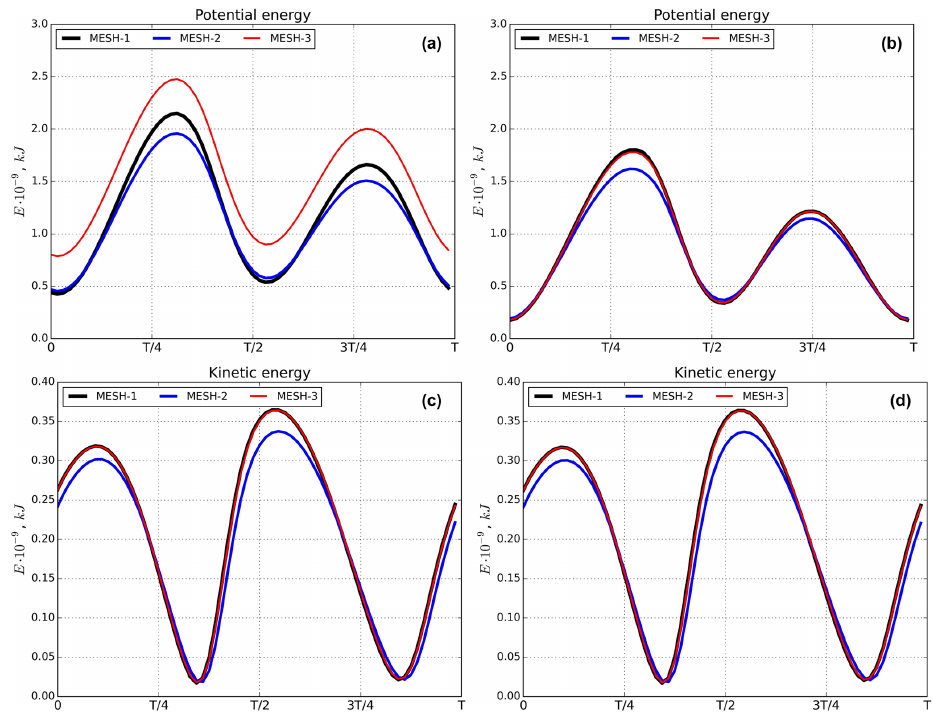
Figure 3. Potential and kinetic energy. Panels (a, c) are for the total area; panels (b, d) are for the area where the full depth exceeds 1m.